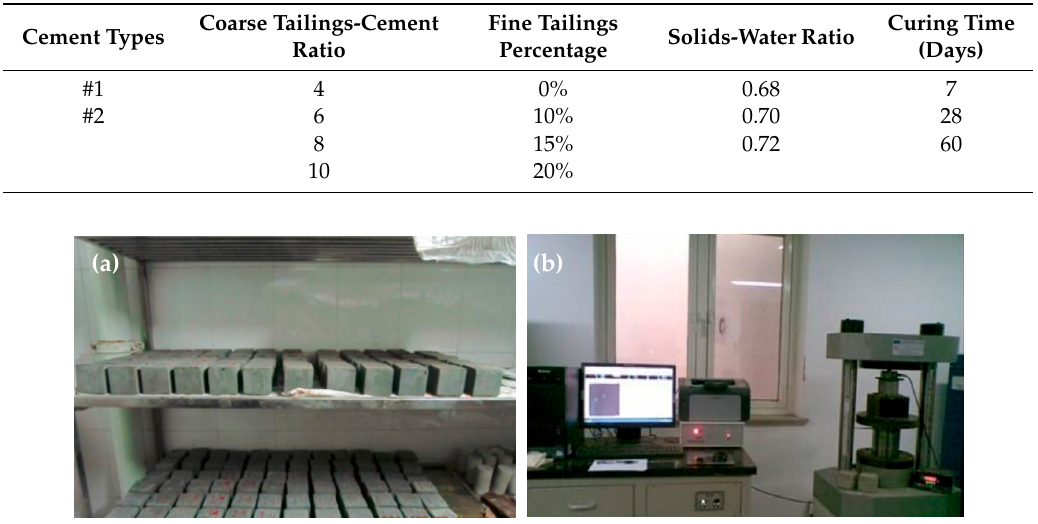
Table 5. The experimental design of CPB.